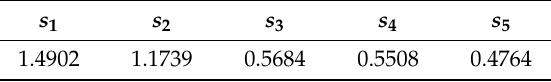
Figure 7. Processing results of the backscattered signal from F1. ( a ) The IMFs extracted; ( b ) the interval in which the flaw echo was located; ( c ) the denoised signal. Table 3. SampEn of the first five